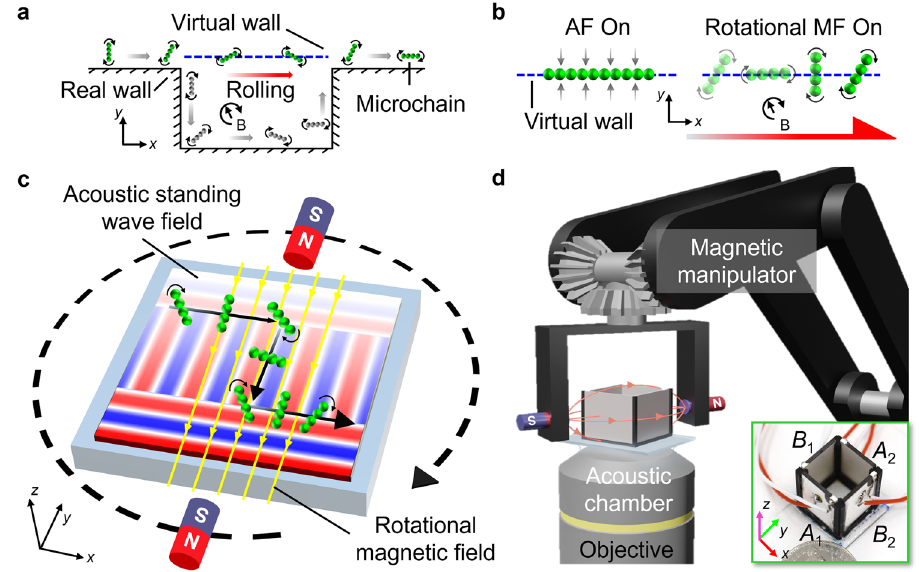
Fig. 1 | Illustration ofchain-shaped microswarms rolling along acoustic virtual walls. a Virtual wall concept. To move from left to right by means of rolling in x − y plane, the gray microchain (conventional methods) has to passively follow the boundary posed by a nearby real wall; in contrast, the green microchain (our strategy) can directly roll forward along the virtual wall. b Mechanism of micro- chainrollingalongone-dimensionalacousticvirtualwalls.(i)Magneticparticlesare pushed to the pressure nodal line by the acoustic radiation force as the acoustic standing wave fi eld (AF) isdeveloped. Gray arrows denote the acoustic virtual wall effect from both sides of the acoustic pressure nodal line, which is denoted by the blue dotted line. (ii) Magnetic particles assemble into microchains and